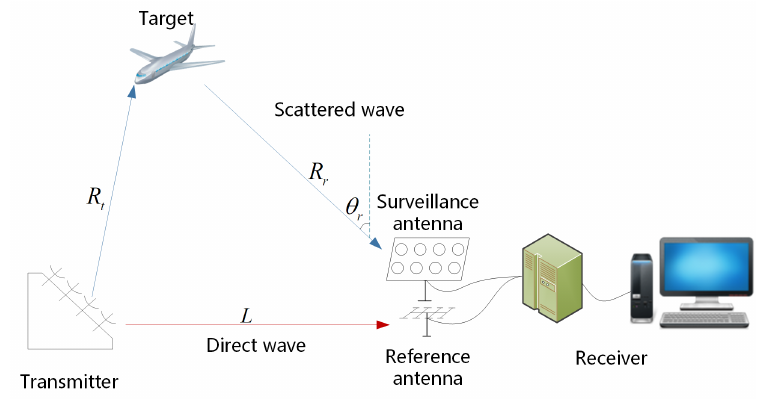
Figure 1. Geometry of the passive bistatic radar (PBR)